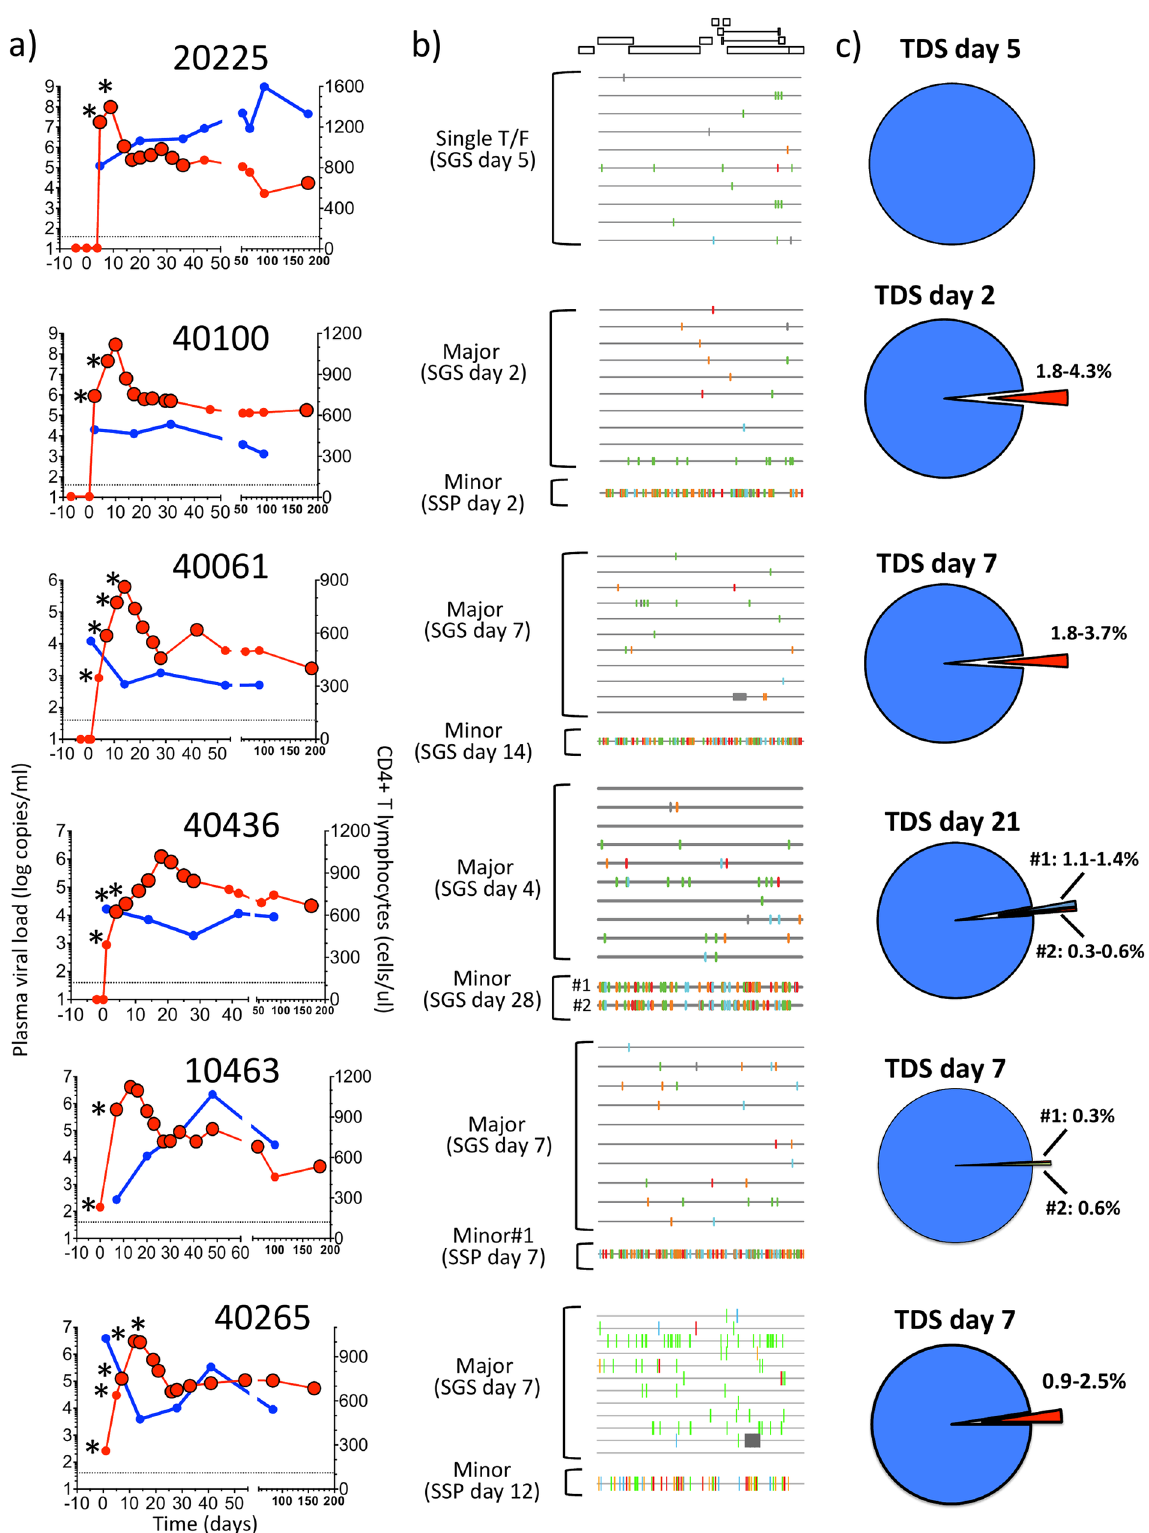
Fig 1. Viral load dynamics and pre-peak viremia HIV-1 genetic diversity in 6 participants from the RV217cohort. a) Plasma viral load (red) and CD4+ T-cell counts (blue) are shownfor six volunteers with documentedNAT-conversion. Day 0 represents the